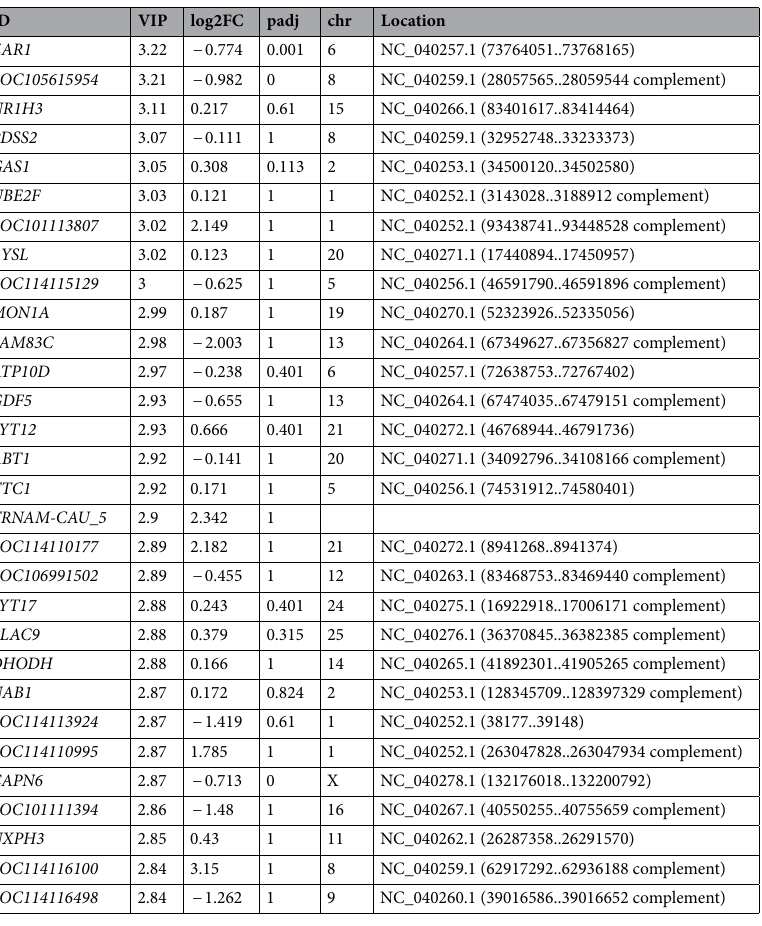
Table 6. Top 30 potential coding biomarkers in male fetal LV tissue exposed to excess T. Top 30 Coding RNA biomarkers comparing control male and T-treated male fetal LV tissue based on variable importance in Projection values. (M2.VIP[3]) along with the corresponding log2FC and padj values obtained from DESeq2 analysis for the same determinants are represented. ncRNA is highlighted in